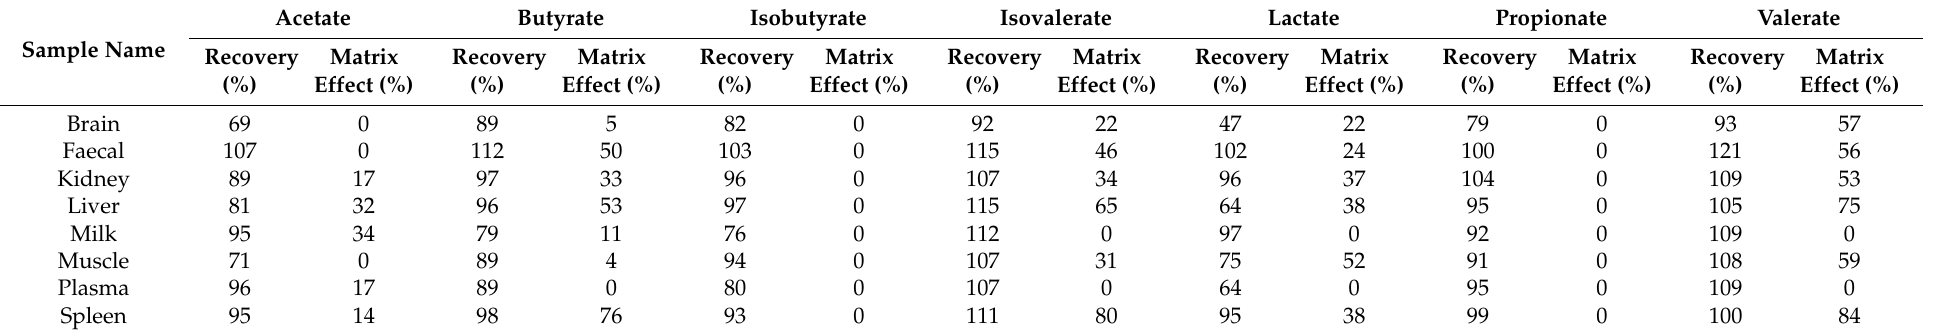
Table 3. Recovery and matrix effect of spiked individual SCFAs, BSCFAs and lactate in appropriate